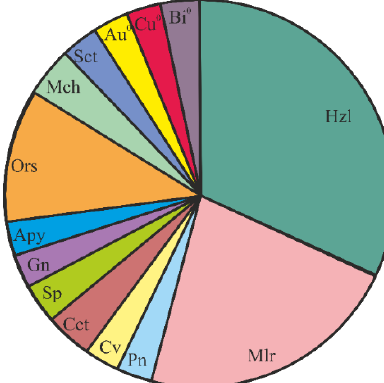
Figure 5. Accessory mineral association in chromitites. Hzl—heazlewoodite Ni 3 S 2 ; Mlr—millerite NiS;